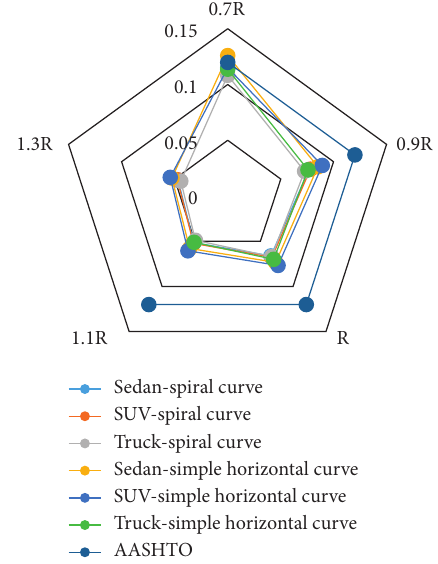
Figure 6: Maximum side friction coefficients in spiral and simple horizontal curves for various vehicle types of sedan, SUV, and truck at 100k/h